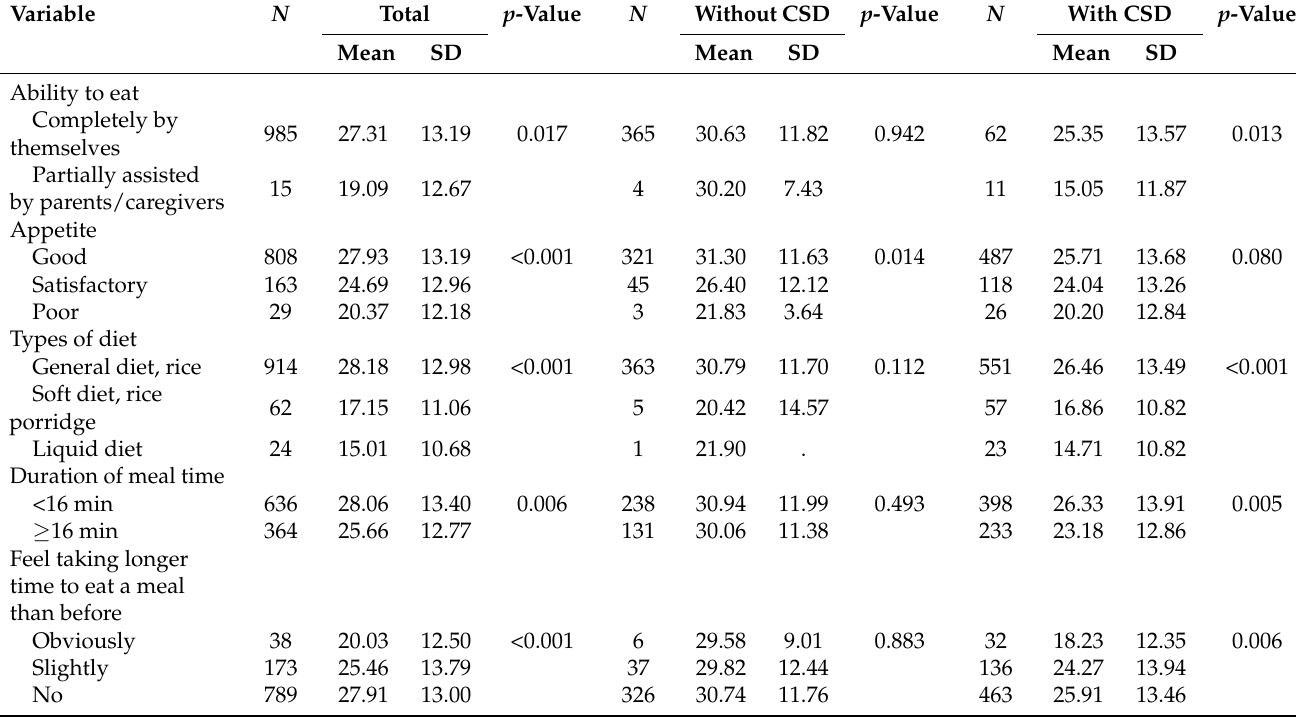
Table 3. Cross table of diet status and tongue pressure of participants by their eating